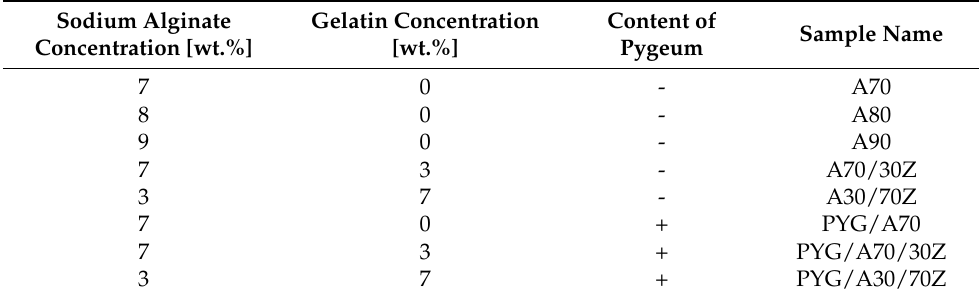
Table 4. Name of the samples and component concentrations in these samples. Sodium Alginate Gelatin Concentration [wt.%]